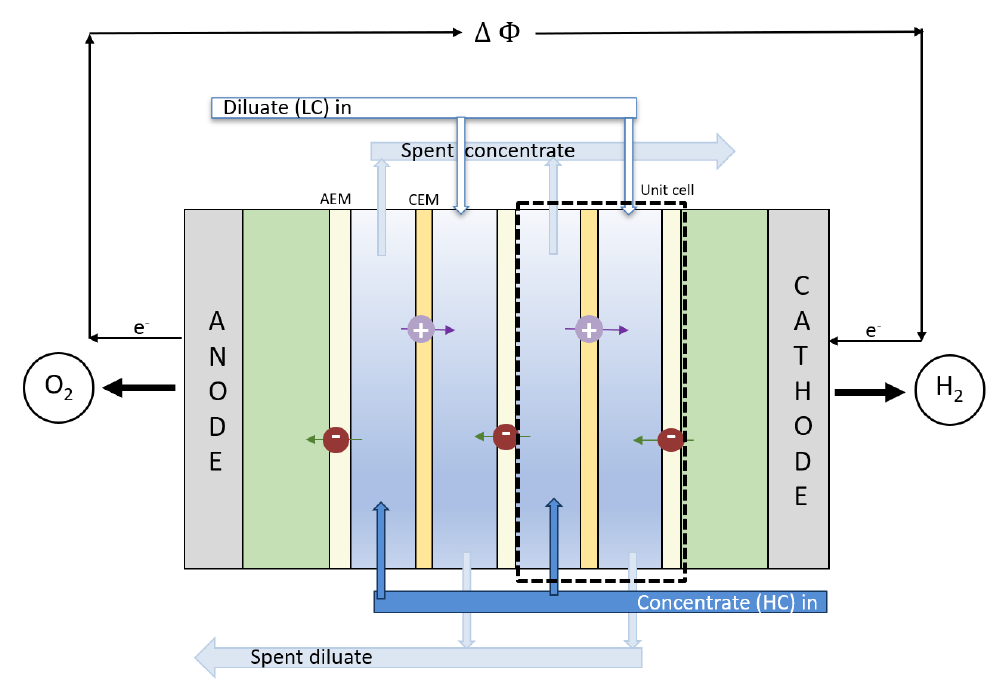
Figure 1. Illustration of a RED stack to be used as the power unit in the REDHE. The stack comprises N number of unit cells with alternating AEMs and CEMs giving an electric potential, ∆ φ , which drives oxygen and hydrogen evolution at the anode and cathode, respectively. As a result, cations and anions migrate in opposite